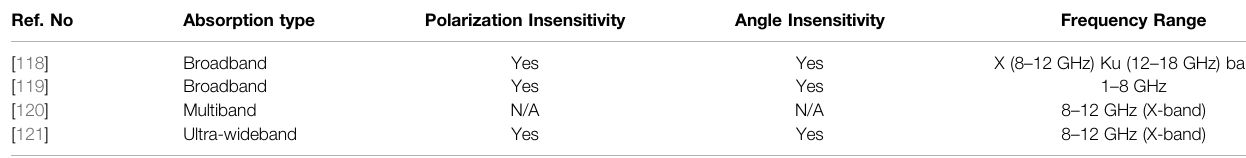
TABLE 1 | Metamaterial absorbers in Microwave Range.